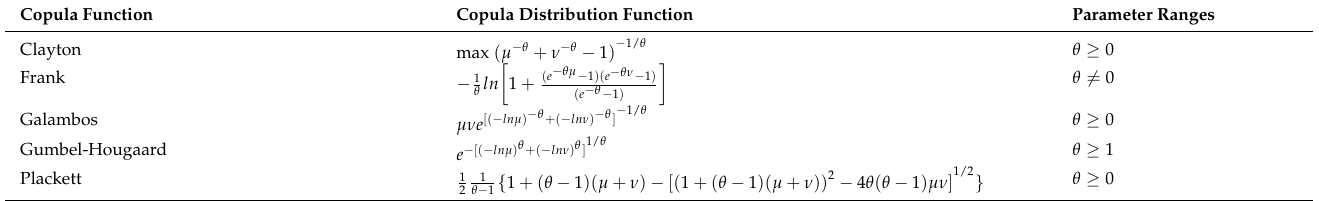
Table 3. Descriptions of the properties associated with the five selected Copula